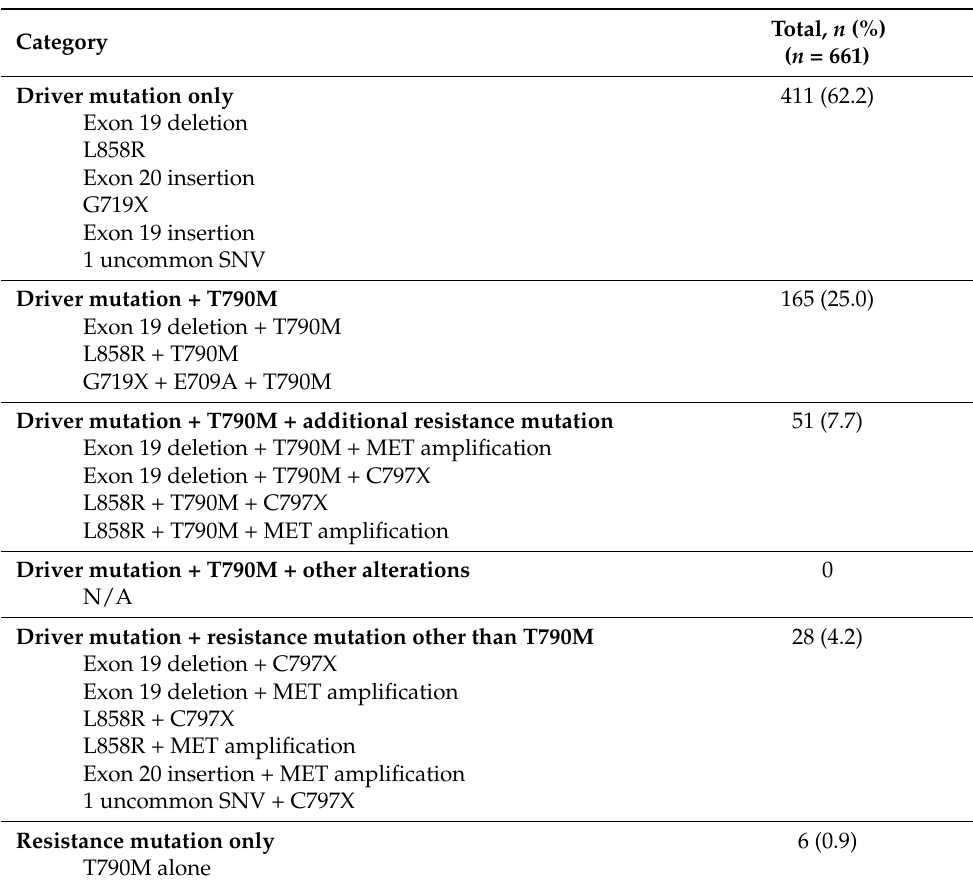
Table 1. Classification of samples with EGFR mutations by presence of resistance